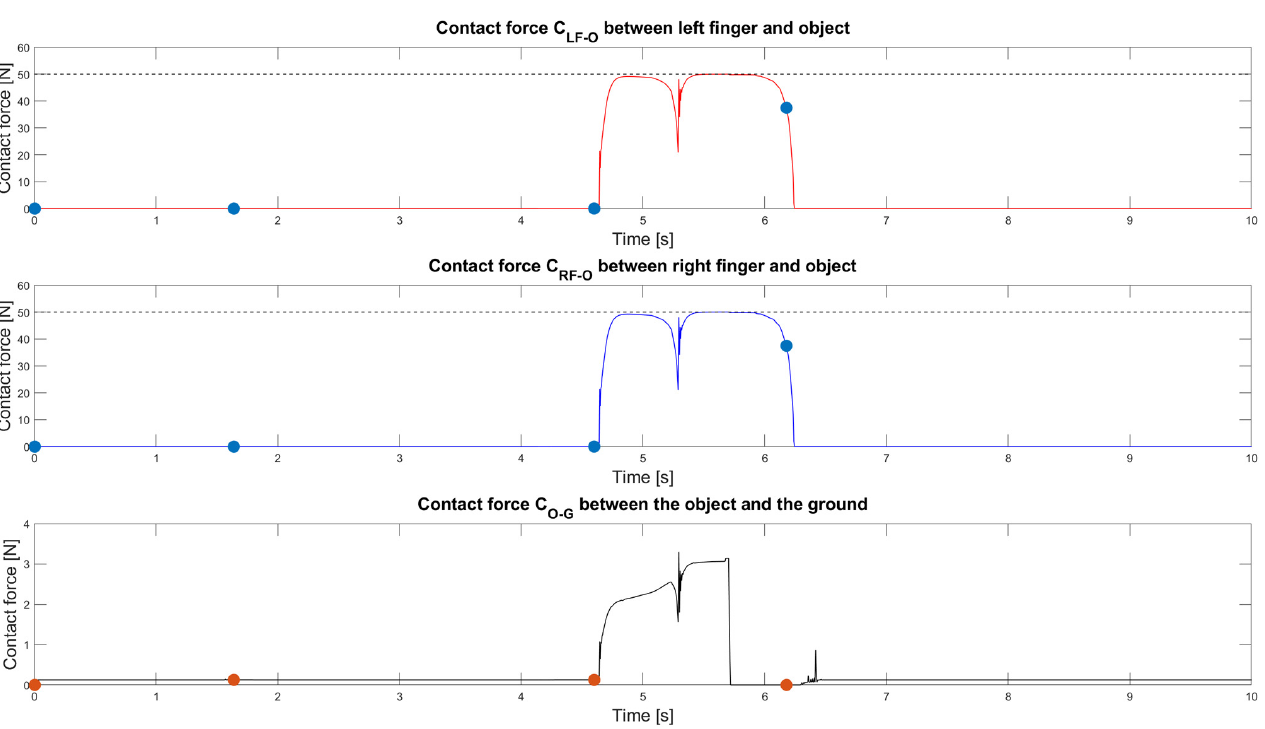
Figure 17. Contact forces between the left and right fingers and the object (red and blue line), and the contact force between the object and the ground (black line) for the second pick-point. The orange and blue circles indicate the events on Figure 16. The dashed line indicates the desired contact force. Source: own.